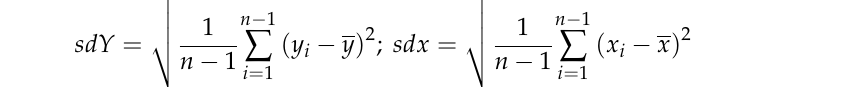
Figure 8. Width and Height of character sequence.